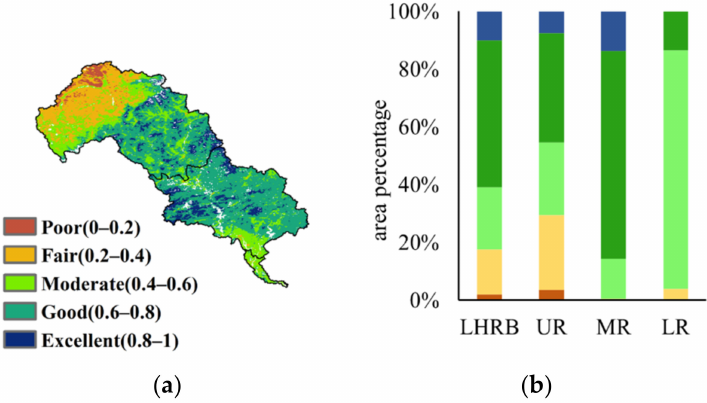
Figure 4. Ecological quality assessment of LHRB ( a ) spatial distribution, ( b ) area ratio bar